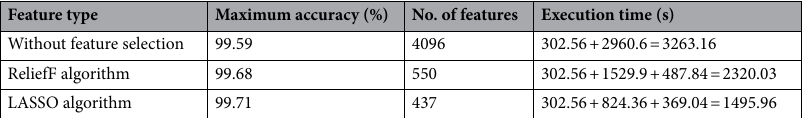
Table 10. Maximum performance of the hybrid approach using the KNN